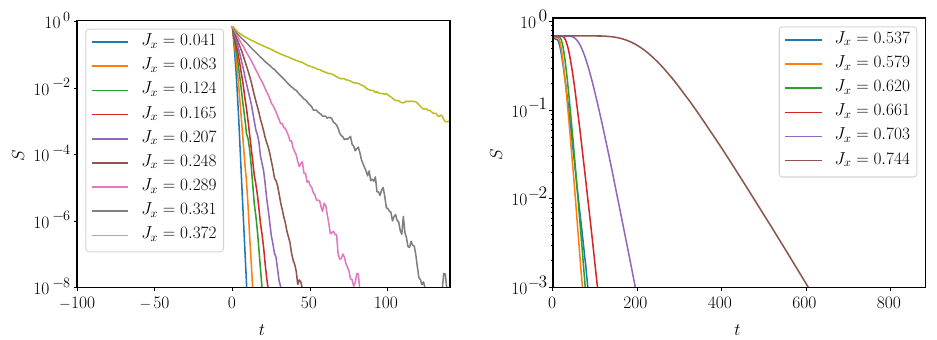
FIG. 13. The entanglement entropy of an ancilla qubit that is initially prepared in the max- imally entangled state with a system of size L = 14, and then evolved with the nonunitary circuit in Eq. (10). Averaging is done over 2000 realizations of the